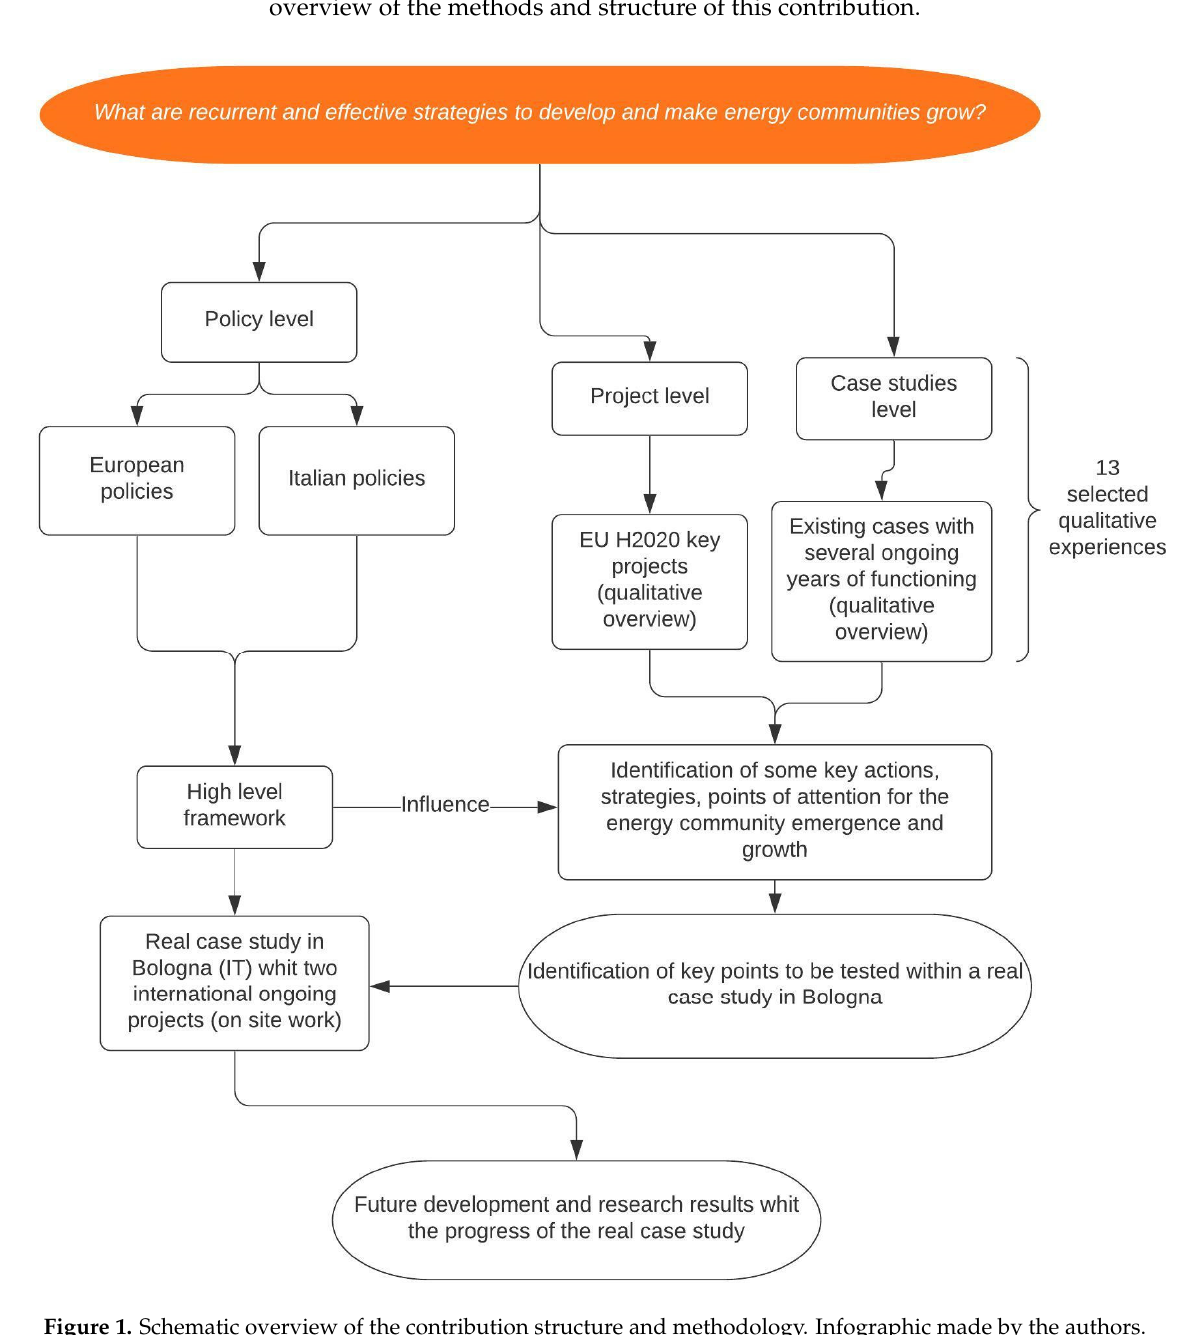
Figure 1. Schematic overview of the contribution structure and methodology. Infographic made by the